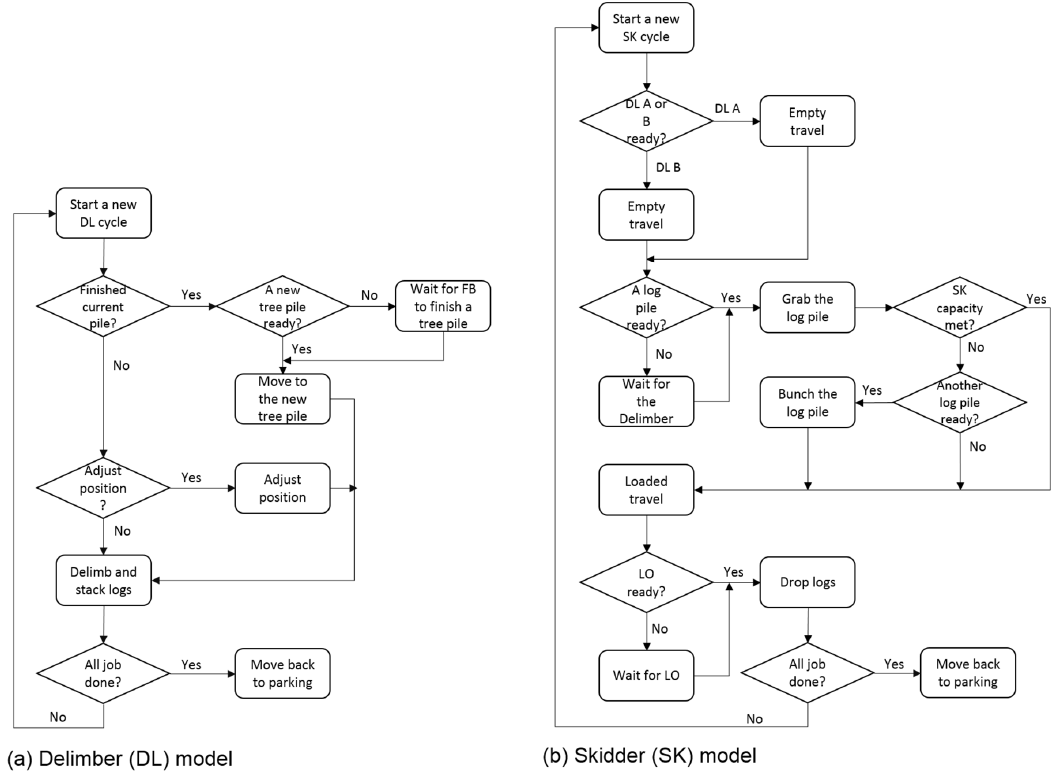
Figure 5. The DES model logic developed for the delimber (DL) ( a ) and skidder (SK) ( b ) in the lop-and-scatter system. The feller-buncher (FB) and loader (LO) have the same work patterns as in the WT DES model (Figure 3a,d), and thus are not presented here.